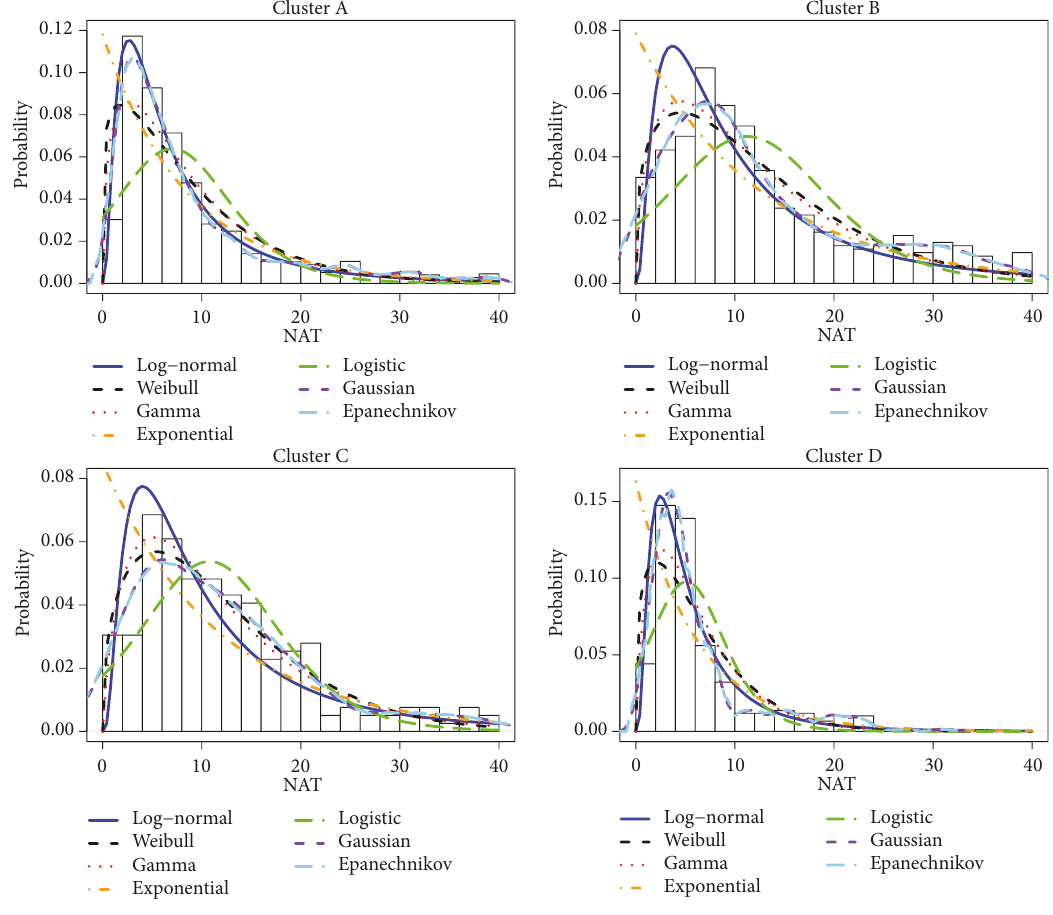
Figure 7: Fitting results of NAT. Table 4: Fitted parameters of NAT and